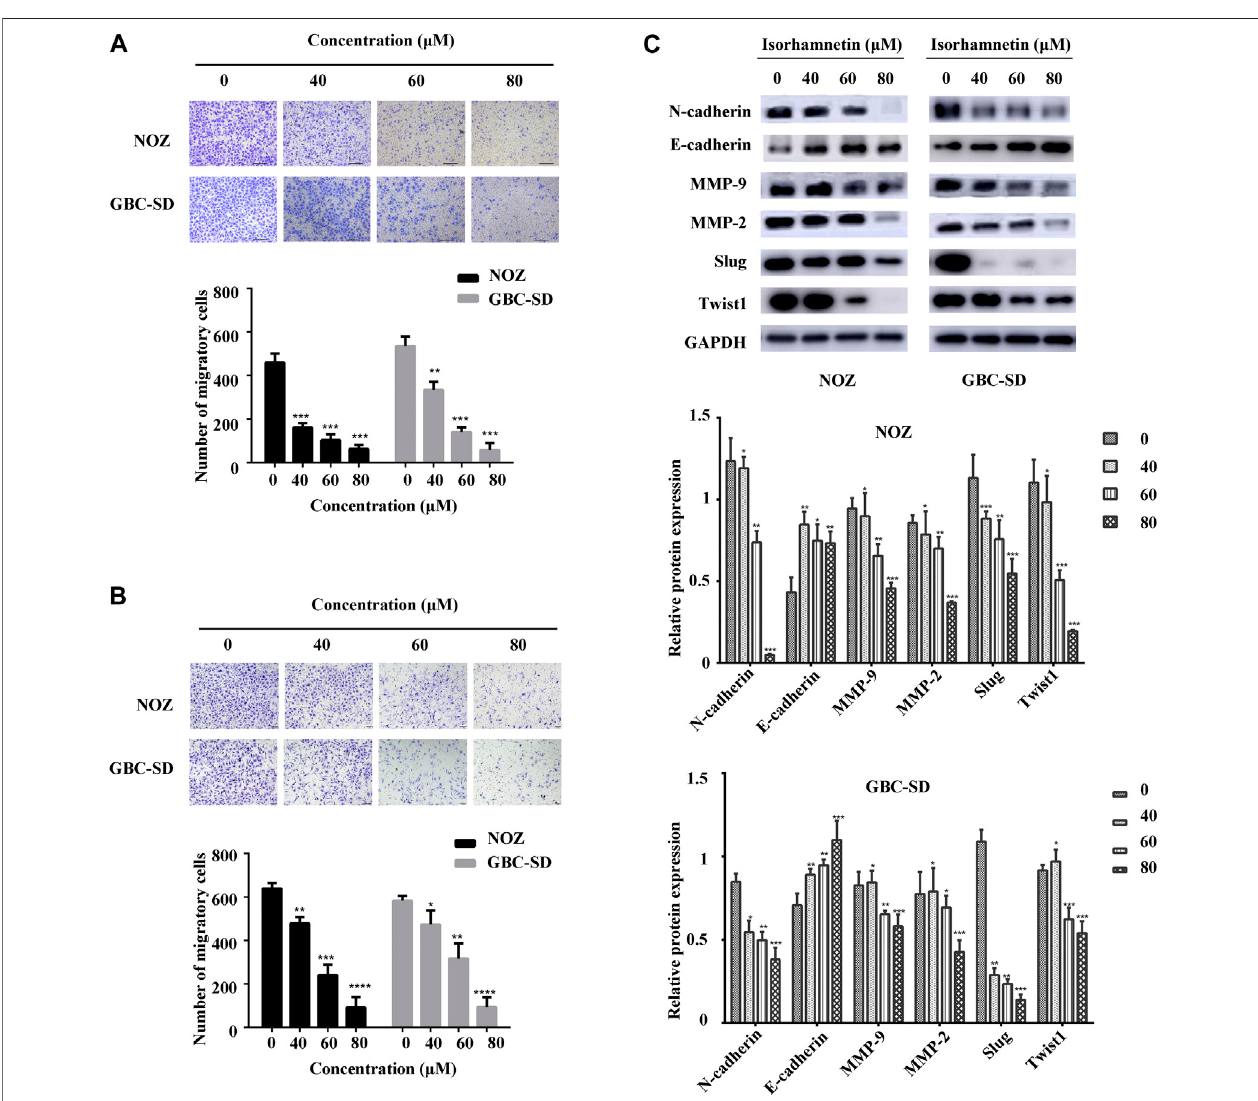
FIGURE2| IsorhamnetinrepressedGBCcellmigrationandinvasion. (A,B) CellmigrationandinvasionofNOZandGBC-SDdetectedafterisorhamnetintreatment (0,40,60,80 μ M)for18 h.Themigratedcellnumberswerecomputed in fi verandom fi eldsineachgroup. (C) TheexpressionlevelsandstatisticresultsofMMP-2,Slug, MMP-9, E-cadherin, N-cadherin, and TWIST1 in NOZ and GBC-SD after isorhamnetin treatment. GAPDH was used as the loading control. * p < 0.05, ** p < 0.01, *** p < 0.001, relative to the control group.